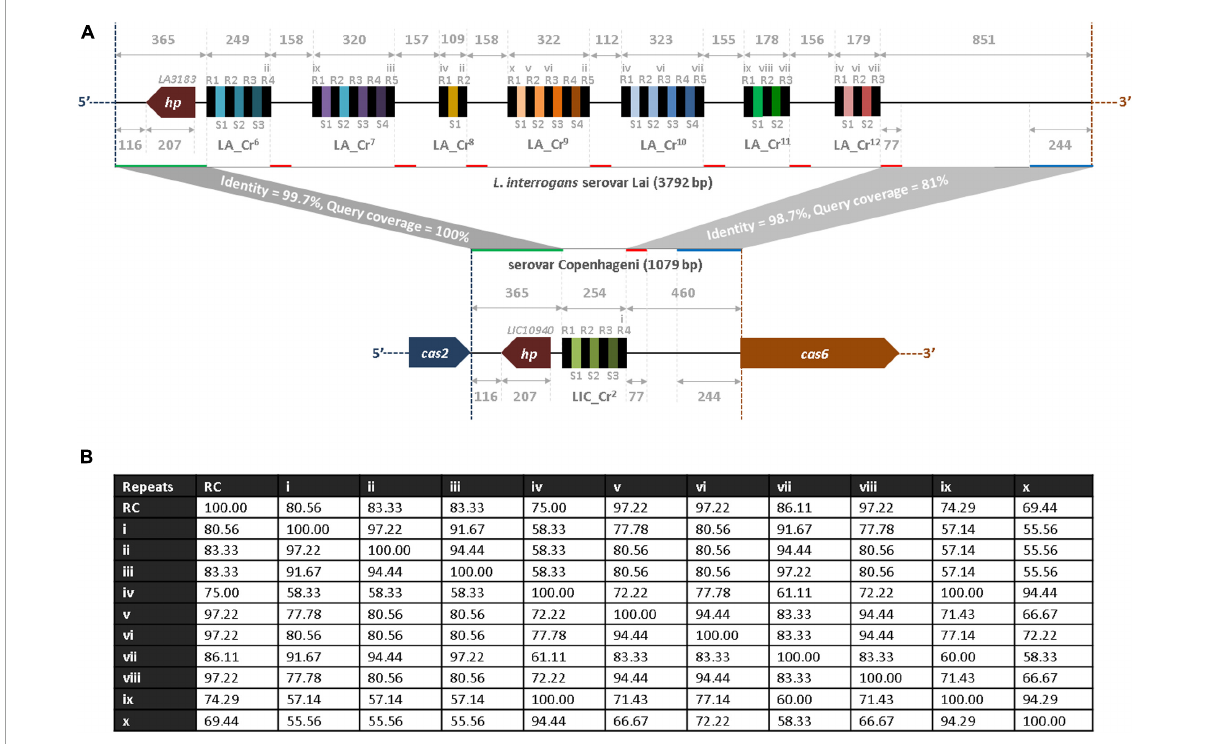
FIGURE2 Bioinformatics analysis of hypervariable region at subtype I-B loci between L. interrogans sv. Lai and Copenhageni. (A) Comparison of the hypervariable region between L. interrogans serovars, Lai and Copenhageni. The region between cas2 ( LA3182 and LIC10941 ) and cas6 ( LA3189 and LIC10939 ) orthologs in serovar Lai (3,792 bp; top panel) and Copenhageni (1,079 bp; bottom panel) are drawn (manually) to scale in the 5 (cid:48) -3 (cid:48) direction of the CRISPR-Cas I-B. Highly similar regions between serovar Lai and Copenhageni are shown by the same color-coded horizontal lines (green, red, and blue) along the lines (solid gray) that correspond to the hypervariable region in Leptospira serovars. Identical genes ( hp ; LIC10940 and LA3183 ) in both strains are denoted by the dark red color-filled pentagon. Black and unique color-filled rectangles represent similar repeats and spacer regions in all CRISPRs. Different variants of repeats (i-x), except the repeats identical to the consensus sequence, are indicated over the black color-filled rectangles in the architecture. (B) Identity matrix of repeat consensus (RC) and variants. A total of 11 repeat sequences (RC and variants i-x) were aligned and an identity matrix was generated using the MAFFT program. The numbers in the matrix correspond to the percent identity between the two respective repeat